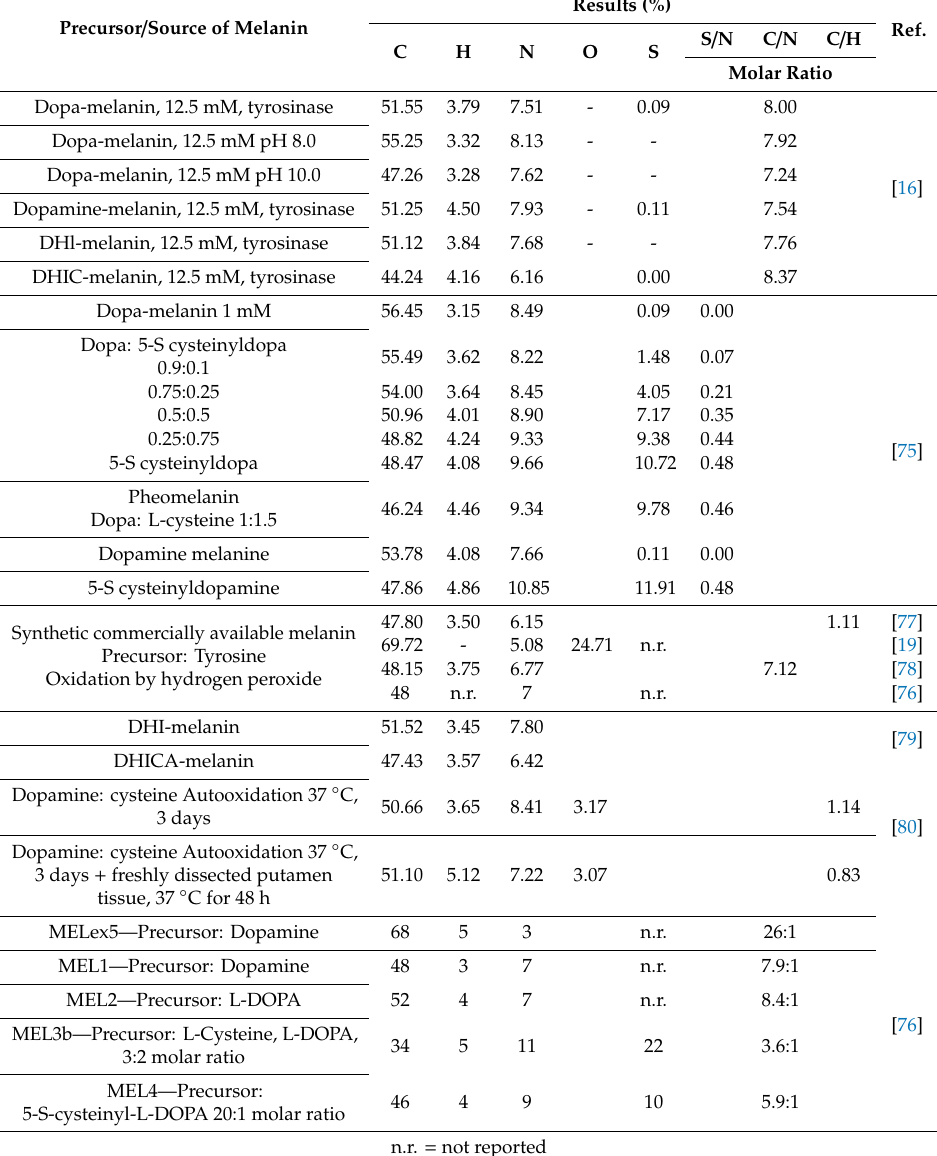
Table 5. Elemental analysis of